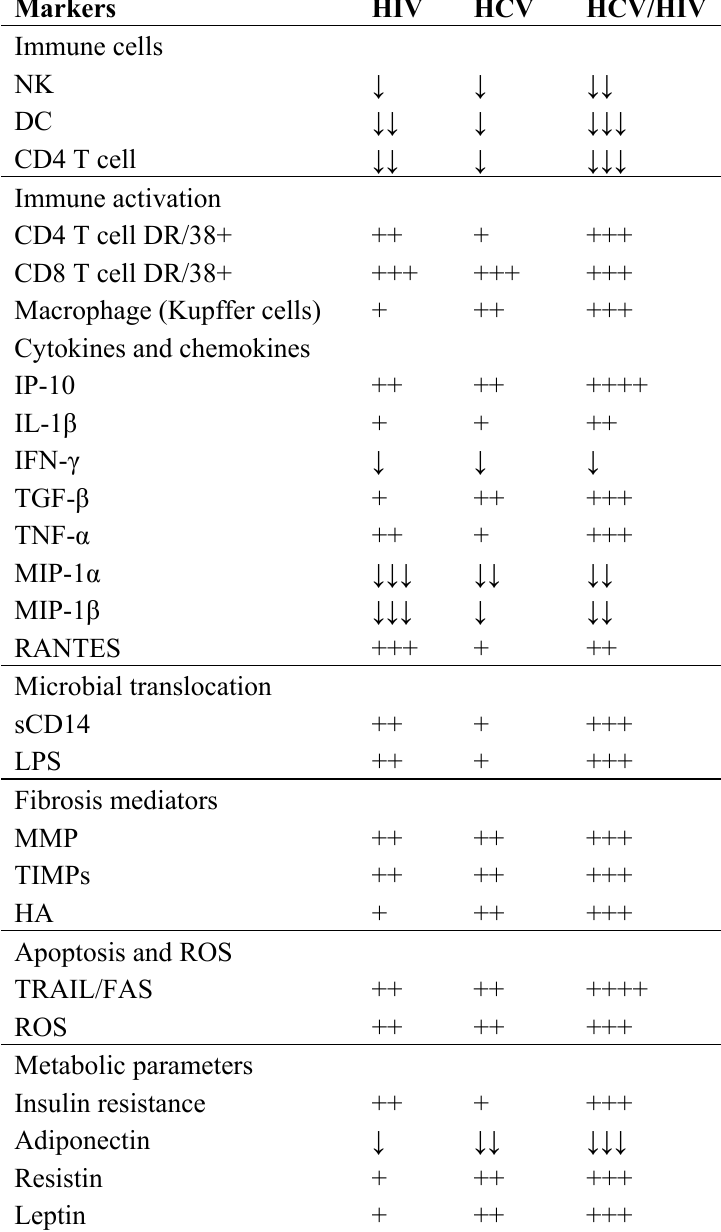
Table 1. Factors associated with liver fibrosis in HIV, HCV and HIV/HCV co-infection.